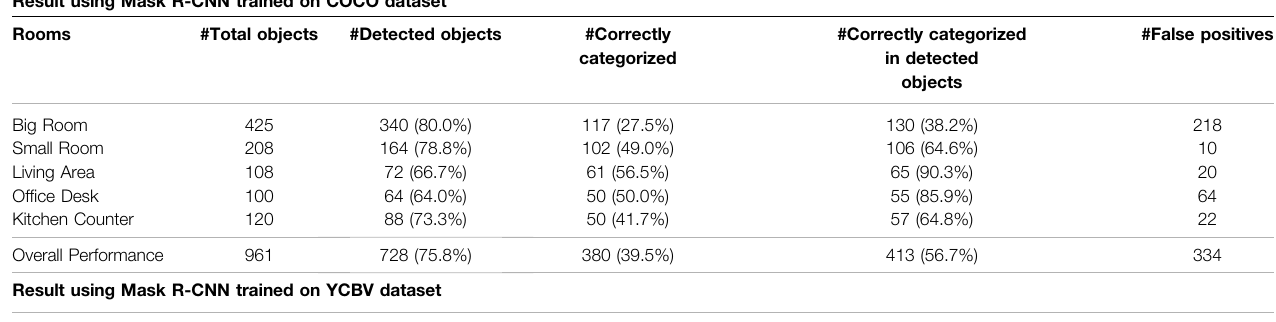
TABLE 4 | Results of the baseline trained on COCO and YCBV compared to the results of our method evaluated on ObChange and averaged per room. Result using Mask R-CNN trained on COCO